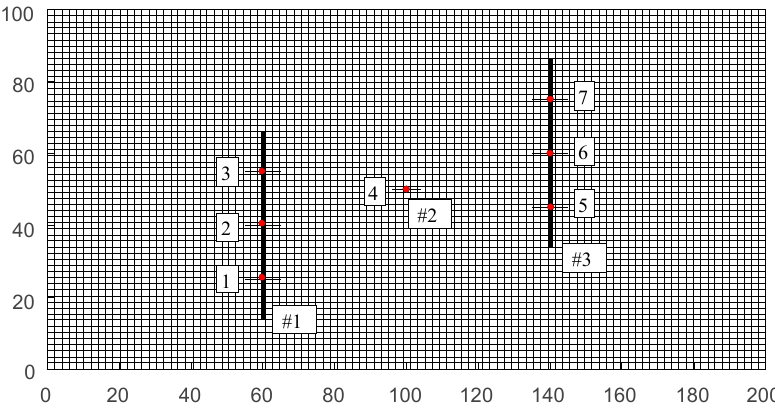
Figure 12. Multi‑well and multi‑cluster simultaneous fracturing